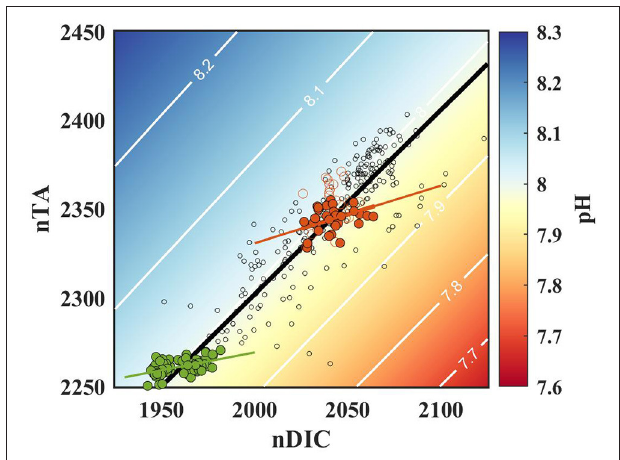
FIGURE 6 | Salinity normalized (36.5) nDIC and nTA at Hog Reef (red circles), Bailey’s Bay (green circles), and across the Bermuda coral reef platform between 2007 to 2012 (open black circles), and the resulting seawater pH (contours; salinity = 36.5, temperature = 27.5 ◦ C). Open red circles represent data from deep stations, and were not included in the model II regression. Solid red, green, and black lines represent model II regression for the Hog Reef, Bailey’s Bay, and the reef platform,